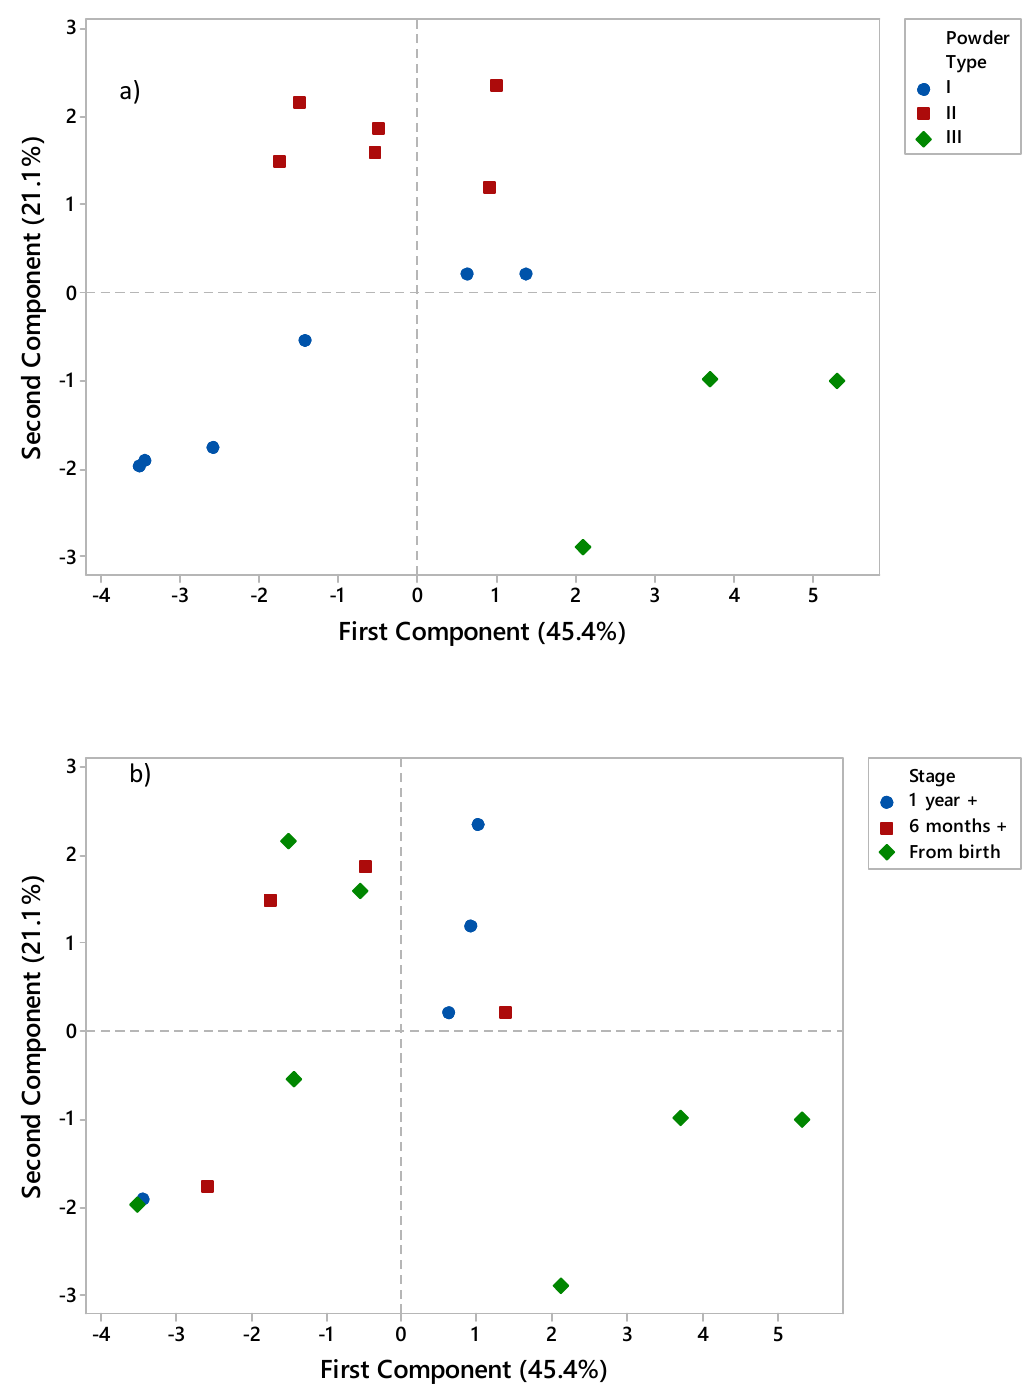
Figure 6. Principle Component Analysis score plots of measured variables segregated based on ( a ) powder type and ( b ) powder stage, i.e., the intended age of the consuming infant. Percentage values noted in the axes relate to the proportion of variability which is described by the respective principle component. Note: Type I powders were made from intact proteins and did not contain large lactose crystals; Type II powders were made from intact proteins and contained large lactose crystals; Type III powders were made from hydrolysed proteins with some powders containing large lactose crystals and starch .